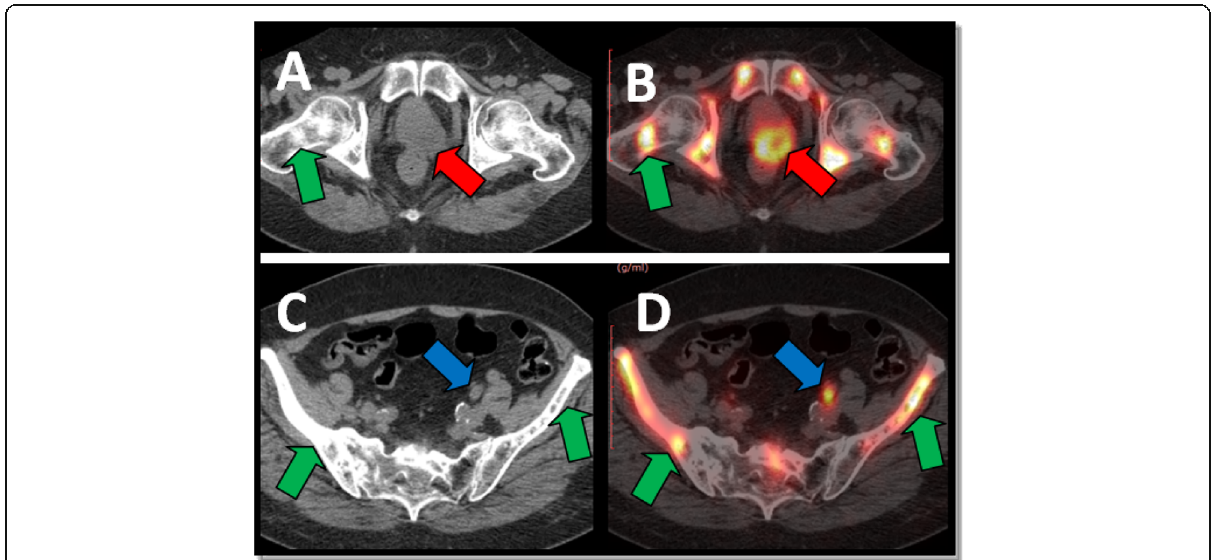
Fig. 4 Axial non-contrast CT and PET-CT images for a 60-year-old male patient with history of prostate cancer for which he had chemotherapy and radiotherapy. Images a and b showed prostatic lesion with 68Ga-PSMA activity with SUVmax = 17.5 with posterior extra-prostatic extension and obliteration of the recto-prostatic space (red arrows), denoting residual neoplastic lesion. Images c and d showed 68Ga-PSMA activity by metastatic left external iliac lymph node with SUVmax = 10.6 (blue arrows). Images a – d showed 68Ga-PSMA activity by metastatic sclerotic osseous lesions involving the pelvic bones (green arrows)